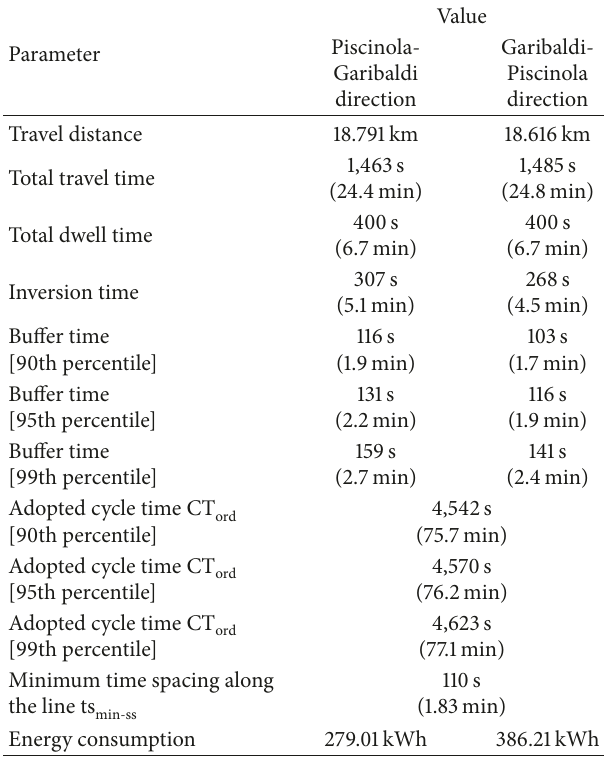
Table 1: Operational parameters of Line